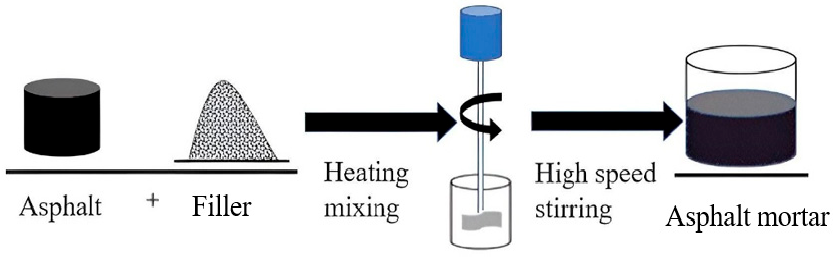
Figure 1. Preparation process of the asphalt mortar.